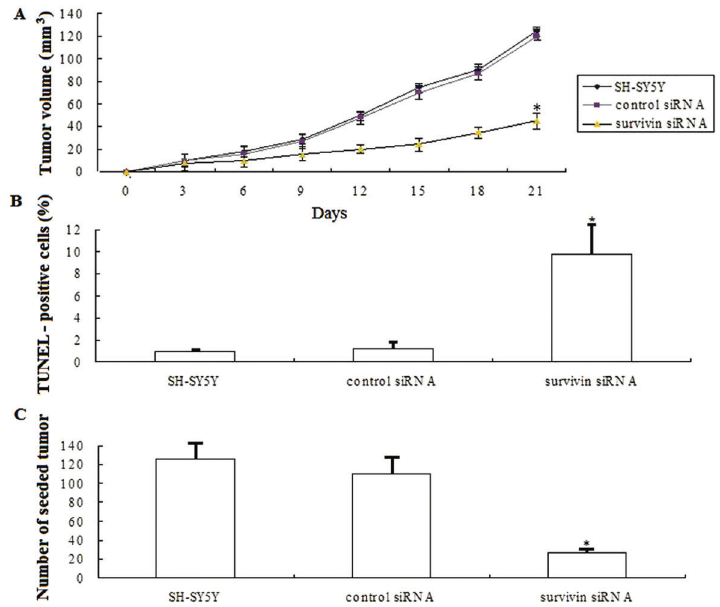
Figure 6. Tumor growth and metastasis inhibition in vivo by survivin siRNA. A , Survival curves of pseudometastatic neuroblastoma-bearing mice in response to survivin small interfering RNA (survivin siRNA) and control siRNA (n=8). B , Terminal deoxynucleotidyl transferase-mediated nick-end labeling (TUNEL) staining performed on formalin-fixed and paraffin-embedded tumor sec- tions of SH-SY5Y subcutaneous tumors. TUNEL staining revealed a massive induction of apopto- sis by survivin siRNA. C , Seeded tumors in the abdominal cavity organs of each animal were evaluated for the extent of metastatic invasion. Data are reported as means±SD of 3 indepen- dent experiments. *P , 0.05, compared to control siRNA (Mann-Whitney